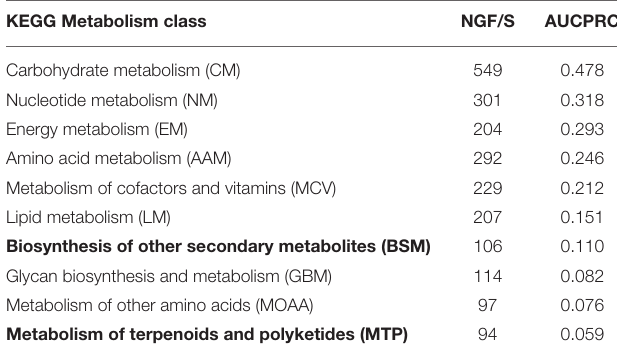
TABLE 4 | Clus-HMC random forest prediction results of metabolic class based on phylogenetic profile of gene families and singleton genes.